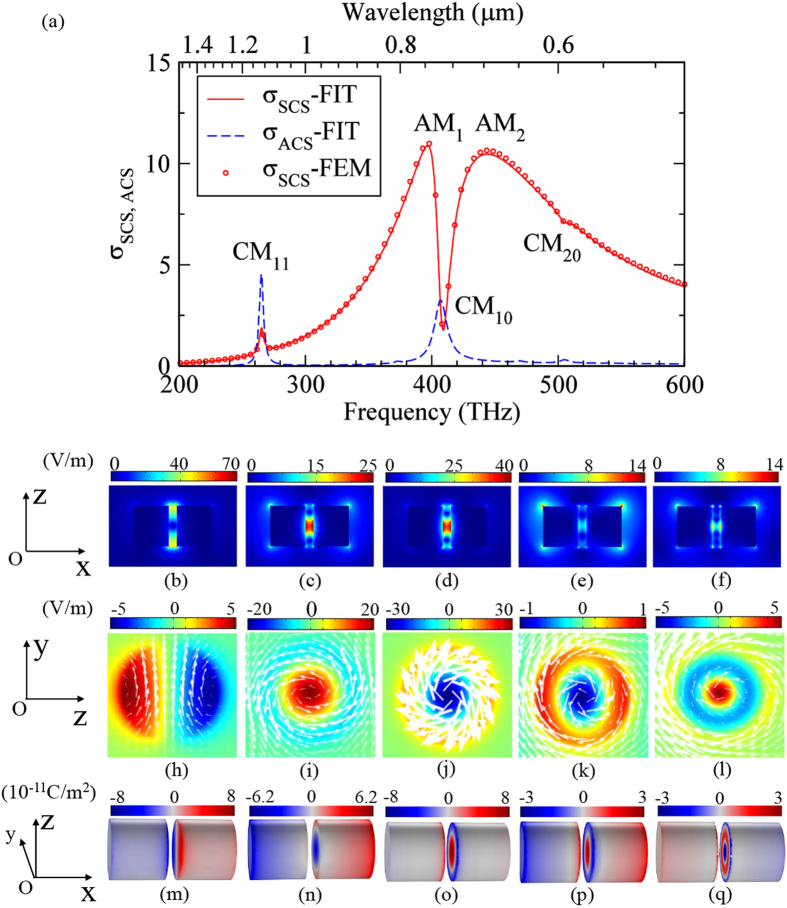
Optical spectra and the near-field details for different frequency.(a) The σSCS (red line) and σACS (blue dashed line) spectra of the PDA with L = 90 nm, R = 50 nm, d = 20 nm and εload = 12. The red dots are results calculated by the FEM. (b–f) The electric field amplitude |E| at xoz plane for CM11, AM1, CM10, AM2 and CM20 in order. (h–l) The out-of-plane electric fields Ex (colors) and the in-plane magnetic field (arrows) at the yoz plane across the dielectric layer. (m–q) The corresponding surface charge distribution.